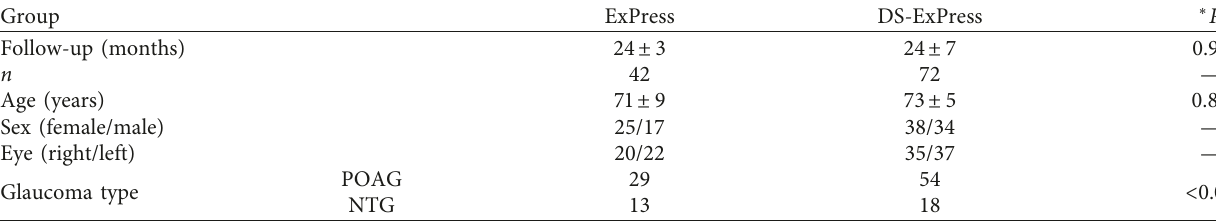
Table 1: Patients’ demographic data.